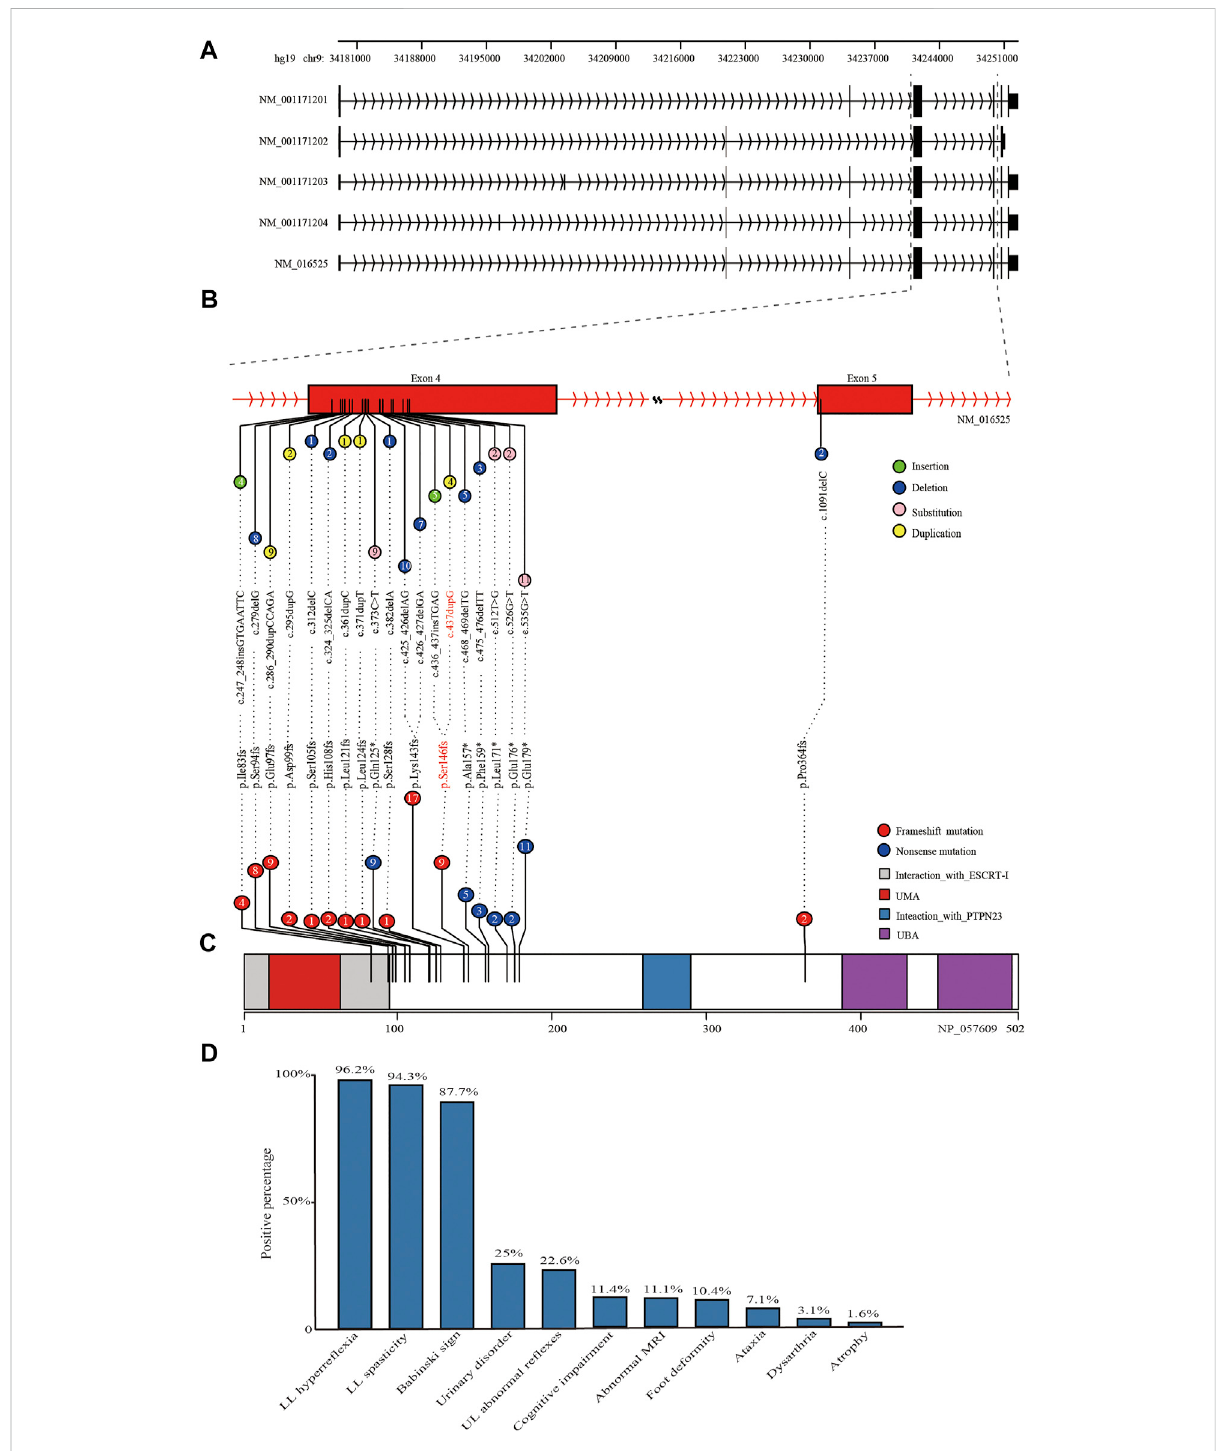
FIGURE 3 Schematic diagram of reported mutations and clinical features of UBAP1-related HSP. (A) The fi ve transcripts of UBAP1 from the database of NCBI RefSeq. All of reported mutations in UBAP1 were displayed in the transcript NM_016,525 (B) and UBAP1 protein (C) . The numbers in lollipop represents the mutation number. The mutation found in our study was marked in red. (D) Phenotypic heterogeneity was observed in HSP patients with UBAP1 mutated. The lower limb (LL) hyperre fl exia and spasticity, positive Babinski sign were the main symptoms in patients with UBAP1 mutation. Nearly one quarter of patients suffered from bladder and upper extremity muscle re fl